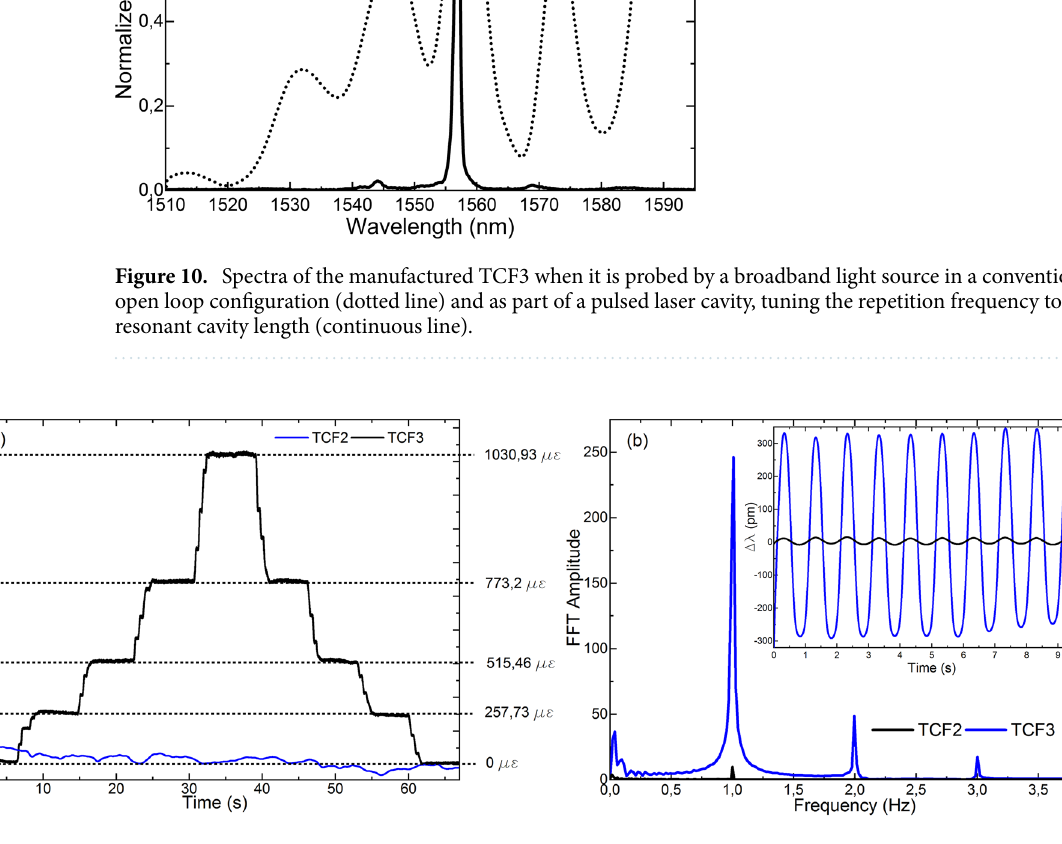
Figure 11. Results when ( a ) TCF3 was subjected to strain and TCF2 was inactive, and ( b ) TCF3 was inactive and TCF2 was vibrating. In the inset, the result in the time domain is